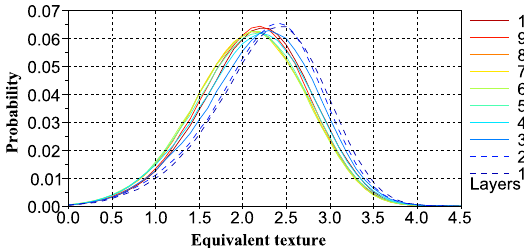
Figure 9. Equivalent texture histogram. The dashed lines represent the lower layers: layers 1 and 2. The shift of the equivalent distribu- tion of those two layers indicates that the median equivalent texture is slightly higher close to the minimum surface.